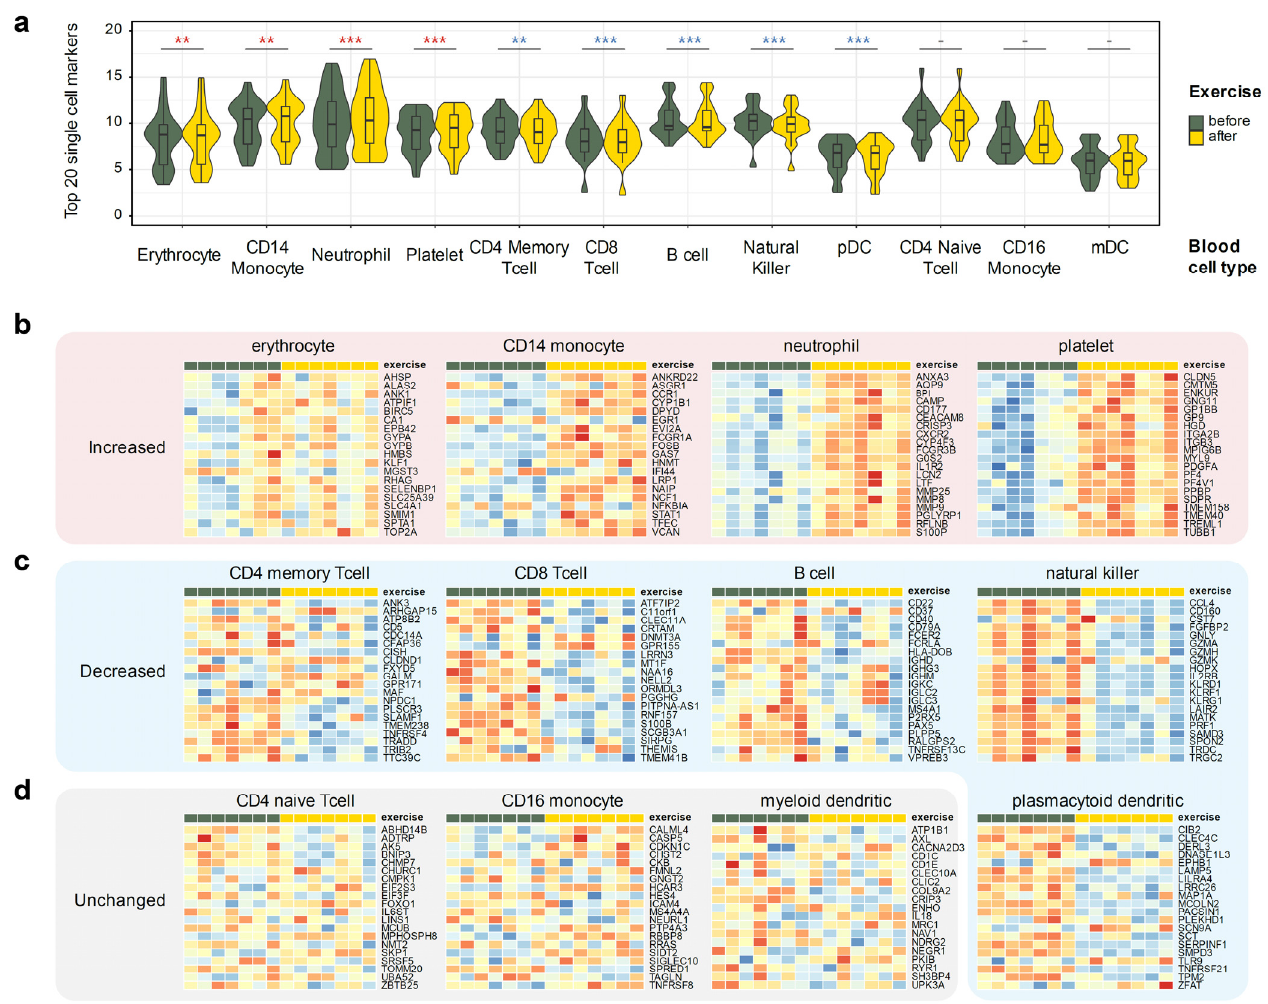
Figure 3. Using single cell markers to infer changes of the cell types from the whole blood RNA-seq data. Twenty markers specific to the 12 listed blood cell types were derived using two public single cell RNA-seq datasets (Methods). Donor-corrected, rlog-transformed expression matrix was used for all heatmap plots. Wilcoxon ranked sum p -value notation: ***, p < 0.001; **, p < 0.01; -, p ≥ 0.05. ( a ) Observed gene expression of 20 cell type markers in all seven profiled donors. ( b ) Cell types that increase after the exercise: neutrophils, CD14+ monocytes, platelets, and erythrocytes. ( c ) Cell types that decrease after the exercise: CD4+ memory T cells, CD8+ T cells, natural killer cells, B cells, and plasmacytoid dendritic cells. ( d ) Cell types that did not display concerted change in markers: CD4+ naive T cells, CD16+ monocytes, and myeloid dendritic cells.